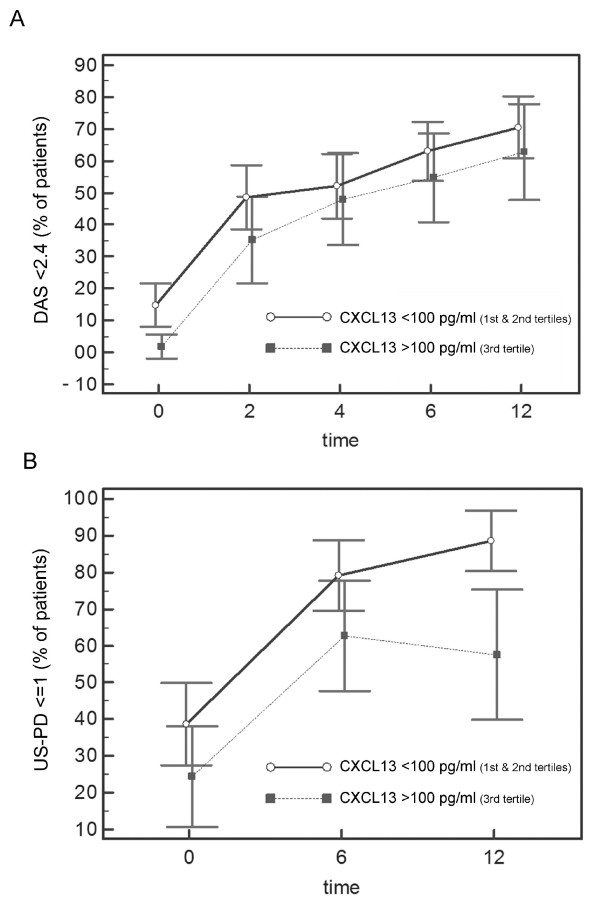
Clinical and ultrasonographic outcomes over time according to baseline CXCL13 levels. Baseline CXCL13 levels and progressive achievement of clinical and ultrasonographic (US) outcomes in patients with recent-onset rheumatoid arthritis treated within a structured treat-to-target protocol aiming at low disease activity. Patients were divided into tertiles based on CXCL13 levels. The proportion of patients achieving low disease activity (DAS < 2.4) (A) and a power Doppler score ≤ 1 at ultrasonography (B) at each time point for different CXCL13 thresholds is shown. The mean ± SD CXCL13 levels were 163.6 ± 63.27 pg/ml for the third tertile (lowest value 99.83 pg/ml), 73.57 ± 12.08 pg/ml for the second tertile and 38.44 ± 10.42 pg/ml for the first tertile. Due to the lack of significant differences between the first and the second CXCL13 tertile, clinical and US outcomes are presented together against the third tertile. Values are the mean ± SD.